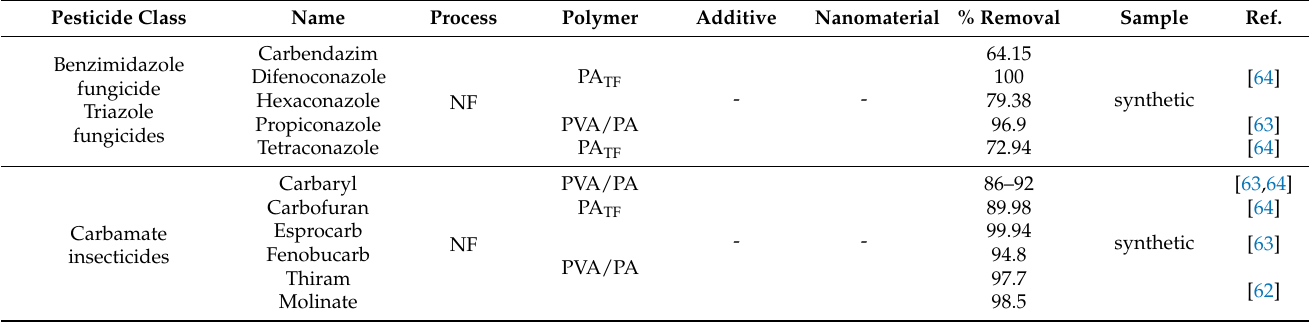
Table 2. Application of polymeric membranes in the purification of water contaminated with